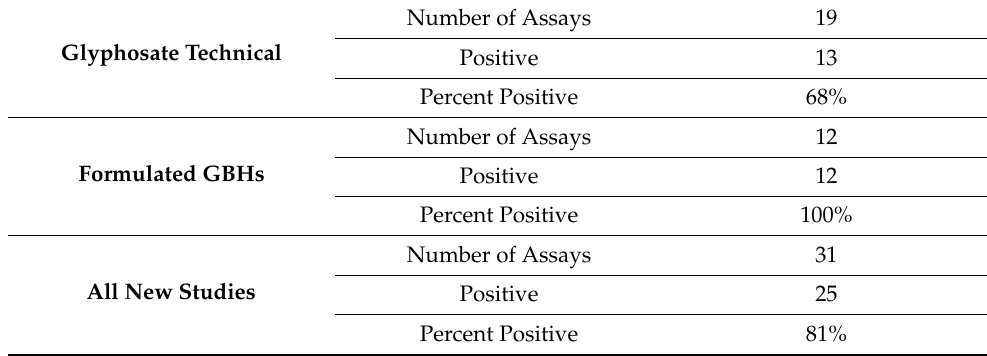
Table 3. Mammalian In Vitro Genotoxicity Assays Published Since the EPA and IARC Reviews of Glyphosate and GBH Oncogenicity. Number of Glyphosate Technical